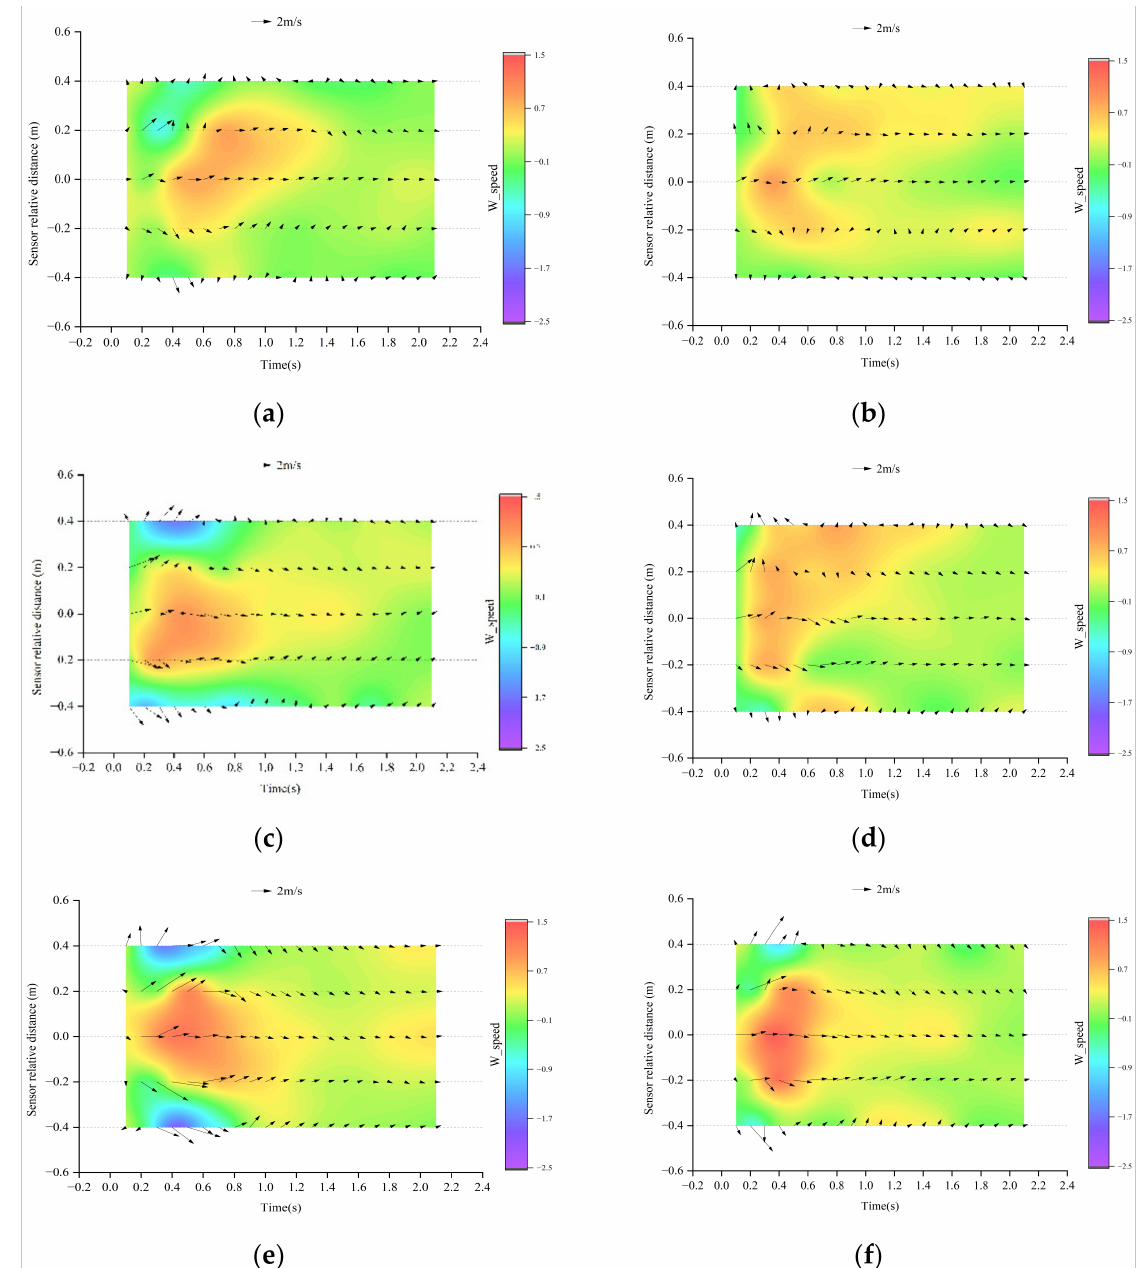
Figure 8. Dynamic wind field at different movement speeds and outlet wind speeds of the air-assisted spray unit: ( a ) movement speed of 0.8 m · s − 1 and outlet wind speed of 9 m · s − 1 ; ( b ) movement speed of 1.2 m · s − 1 and outlet wind speed of 9 m · s − 1 ; ( c ) movement speed of 0.8 m · s − 1 and outlet wind speed of 12 m · s − 1 ; ( d ) movement speed of 1.2 m · s − 1 and outlet wind speed of 12 m · s − 1 ; ( e ) movement speed of 0.8 m · s − 1 and outlet wind speed of 16 m · s − 1 ; ( f ) movement speed of 1.2 m · s − 1 and outlet wind speed of 16 m · s − 1